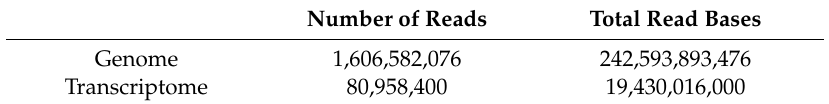
Figure 1. Example of Mirounga leonina , southern elephant seal. Photo by Hyun Park. Table 1. Sequencing data generated for Mirounga leonina genome assembly and